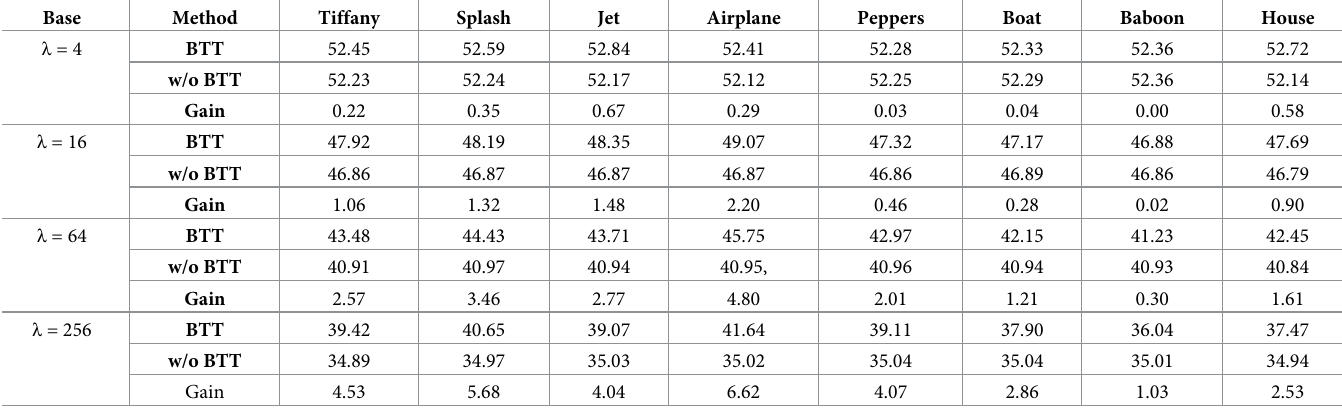
Table 1. PSNR comparisons of using and without using the BTT (in